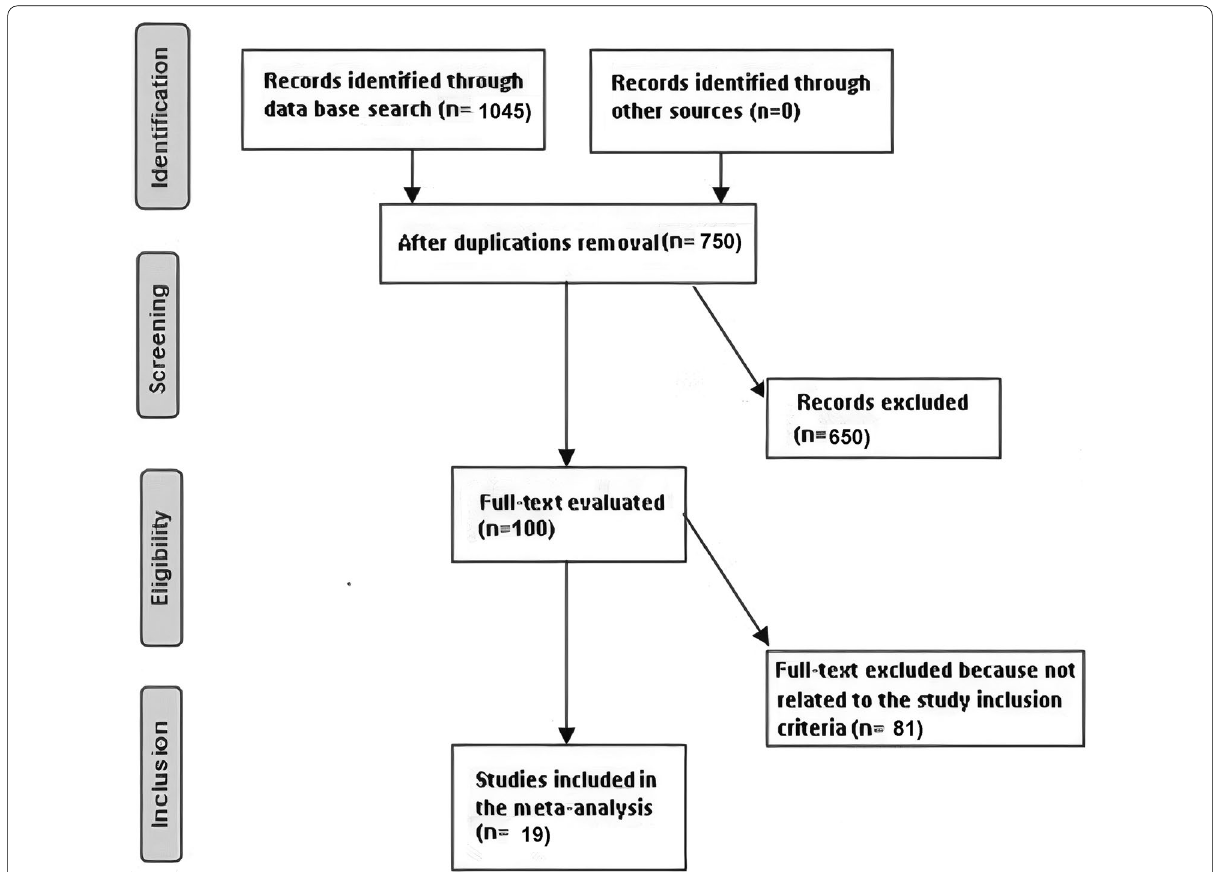
Fig. 1 Diagram showing defined steps of the